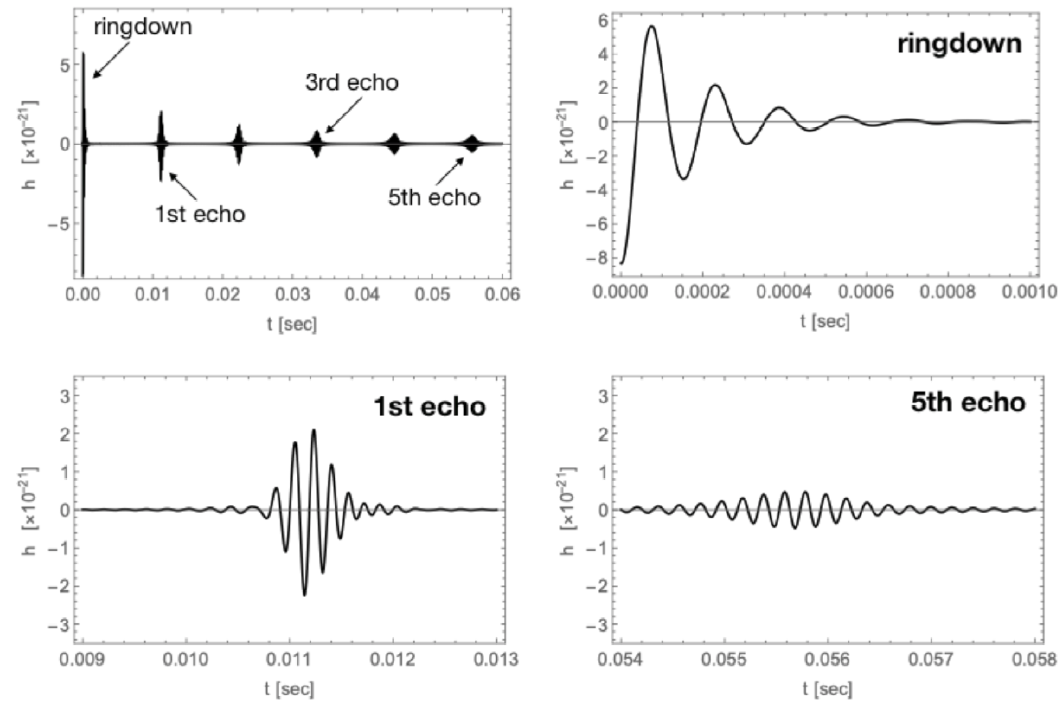
, ¯ a = 0.7, D o = 40 Mpc, (cid:101) rd = 0.04, θ = 90 ◦ , (cid:12)